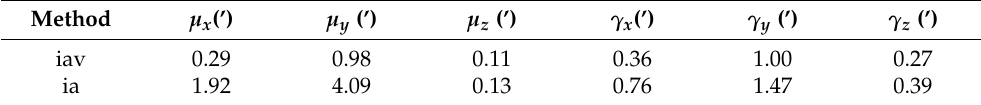
Table 5. RMSE values of µ and γ in the cases of the initial misalignment angles [ 5 ◦ 5 ◦ 20 ◦ ] T .